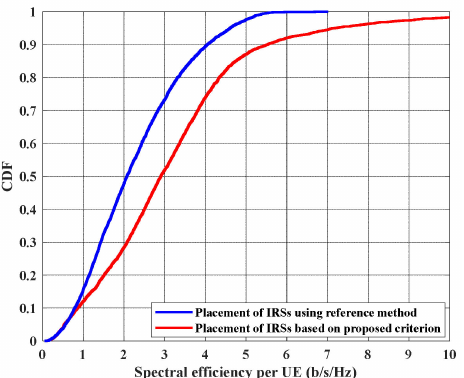
Figure 6. CDF of spectral efficiency per UE when placing the two IRSs using the proposed method, where IRSs positions are in (10, 0) and (10, 20), and using ref. [27] method, where IRSs positions will be in (0, 20) and (20,